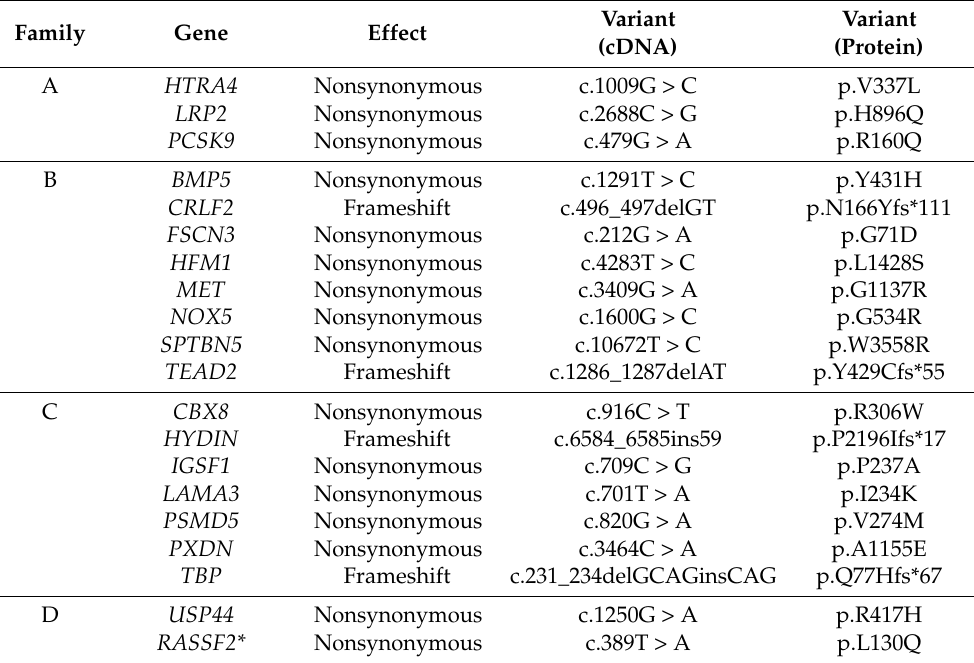
Table 2. Detected overlapping germline variants per